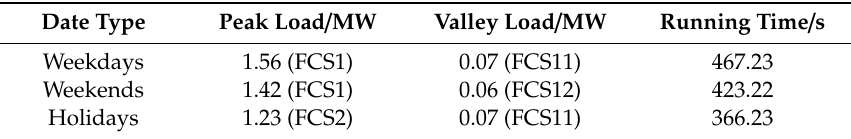
Table 1. Load distribution characteristics of different date types.